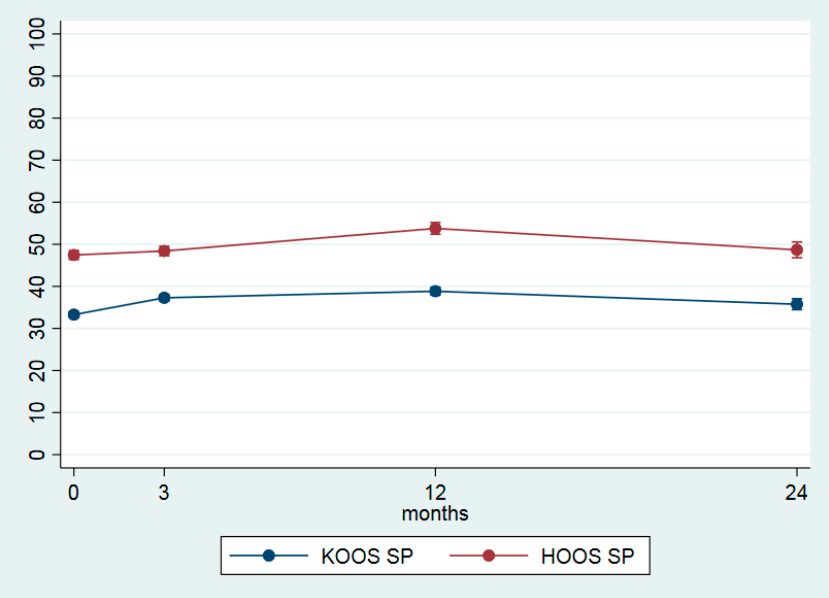
Figure 3. Difficulties in sport-related activities (SP) (HOOS */KOOS **, scale 0 = worst–100 = best) at baseline, 3, 12 and 24 months given by estimated marginal means with 95% confidence intervals. * Knee injury and Osteoarthritis Outcome Score ** Hip disability and Osteoarthritis Outcome Score.